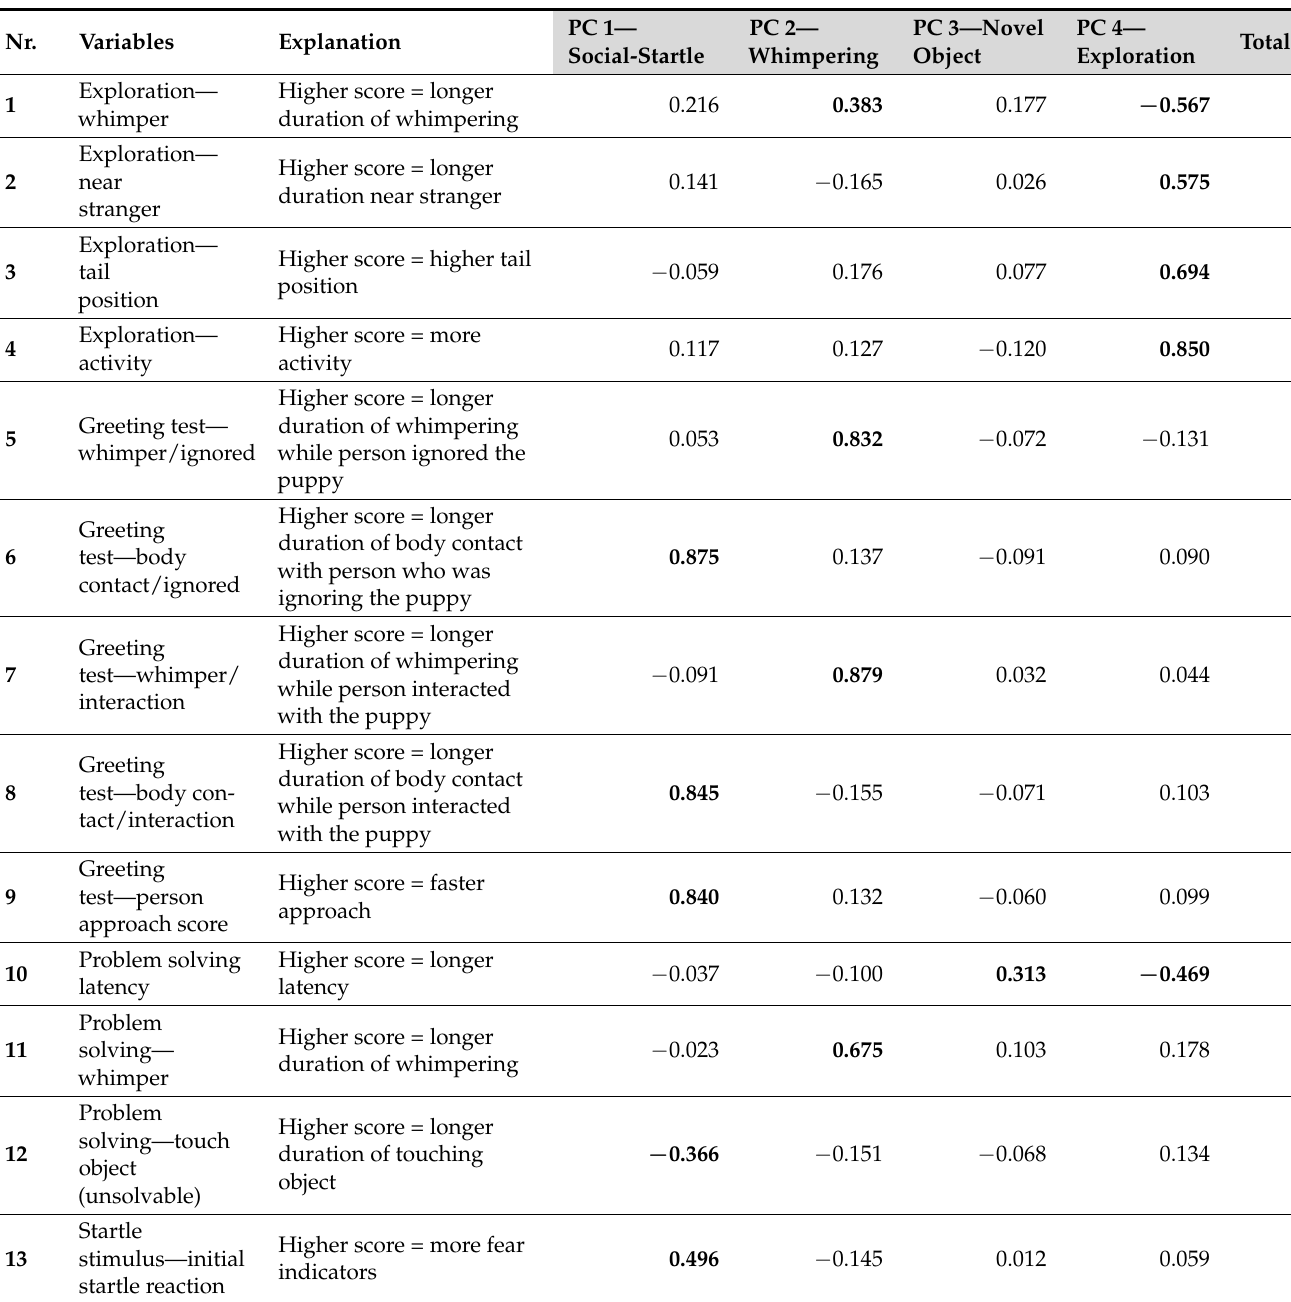
Table 7. Components and component loadings of the CATPCA (Varimax rotation); variable loadings >0.3 are